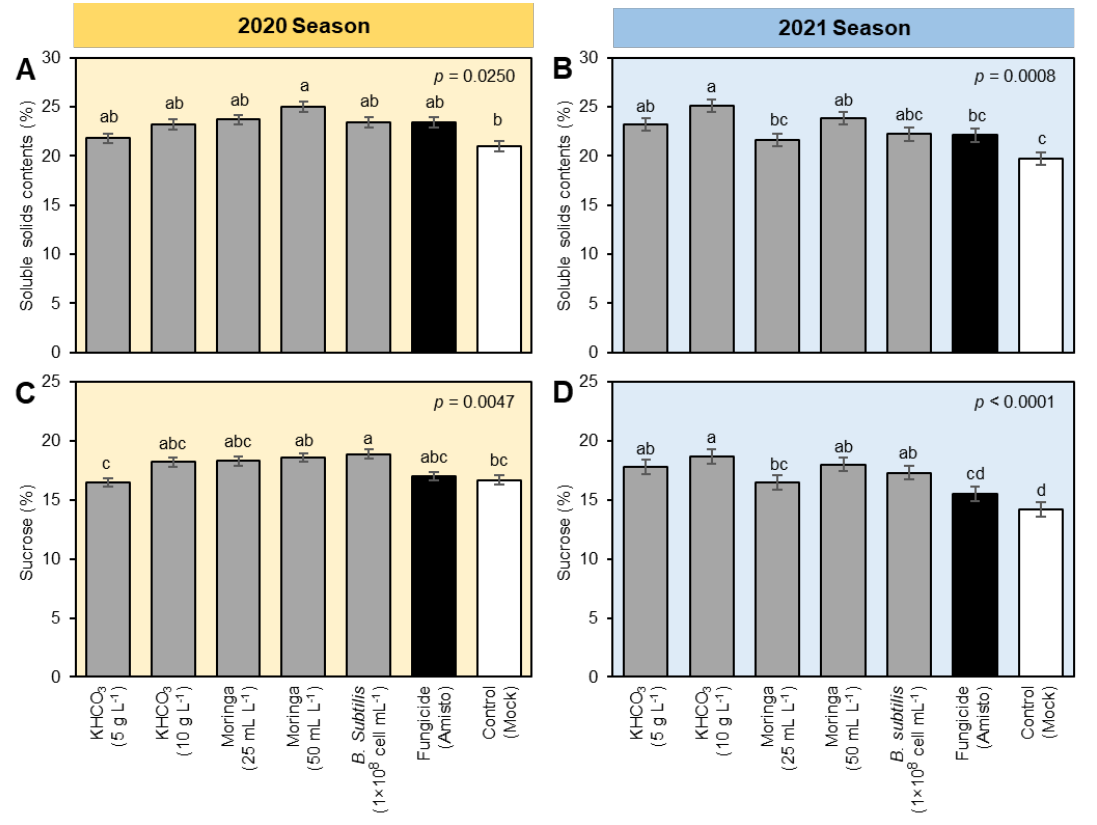
Figure 2. Effect of different treatments on the quality indices of sugar beet plants infected with pow- dery mildew disease caused by Erysiphe betae under field conditions during the 2020 and 2021 seasons. ( A , B ) Soluble solid contents (%) during the 2020 and 2021 seasons, respectively, and ( C , D ) Sucrose (%) during the 2020 and 2021 seasons, respectively. The data presented are the means ± standard deviation (mean ± SD) of three biological replicates ( n = 3). Different letters signify statistically significant differences between treatments according to Tukey’s HSD test ( p ≤ 0.05).